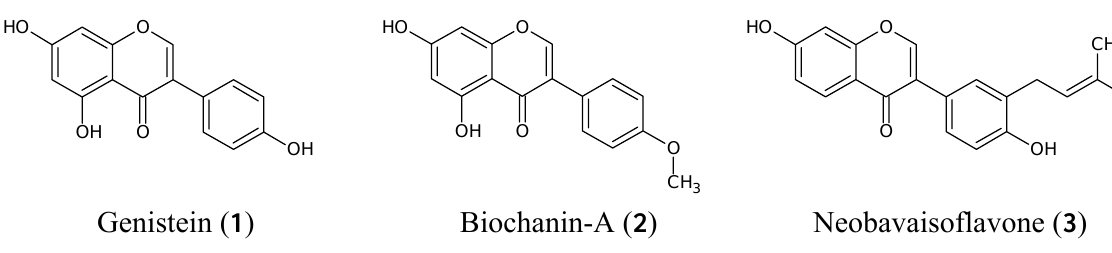
Figure 1. Chemical structures of the tested